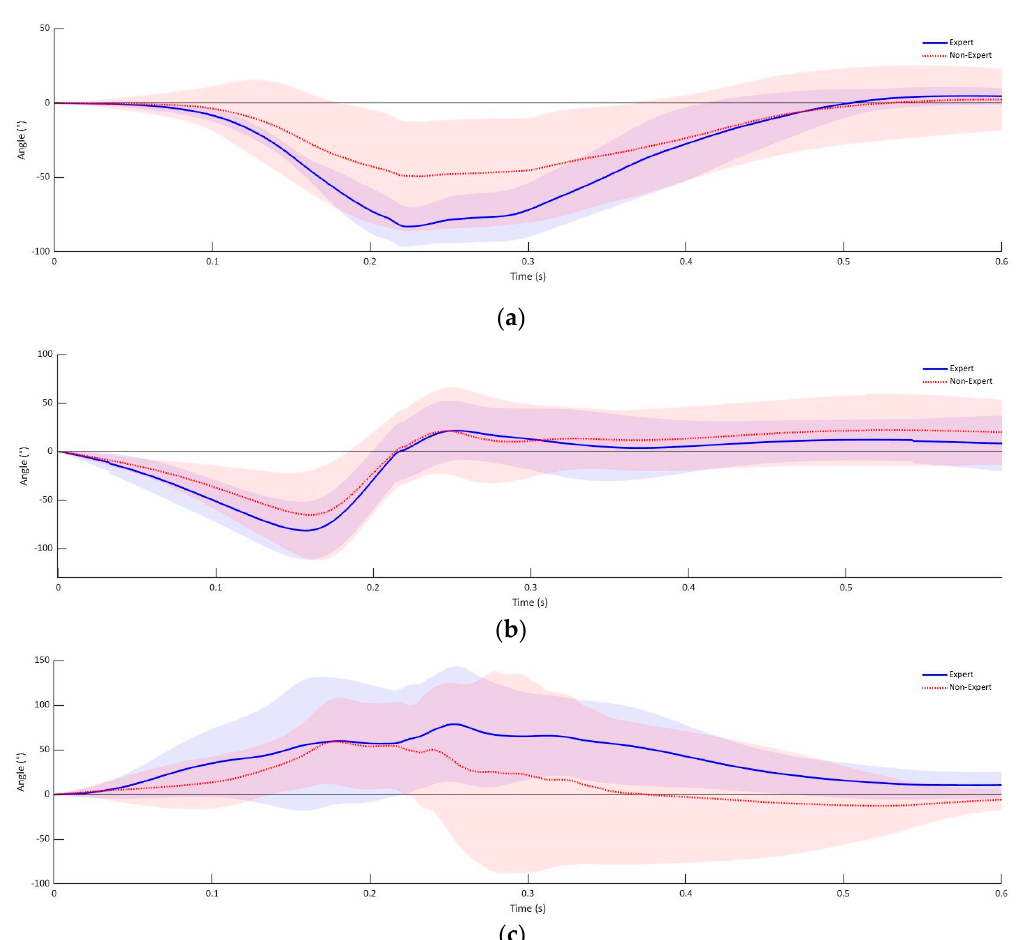
Figure 7. Fist rotation experienced athlete’s uppercut punch: ( a ) longitudinal, ( b ) transversal and ( c ) sagittal axis.